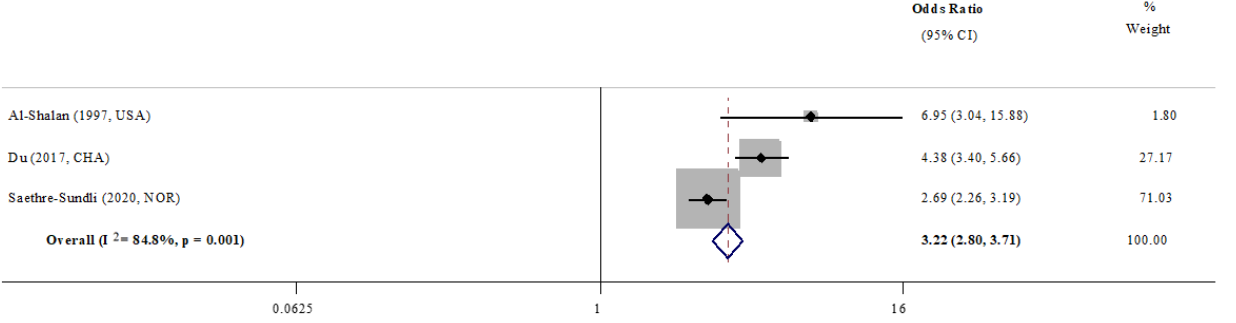
Figure 3. Meta-analysis. Presence of ECC [9,28,29] .